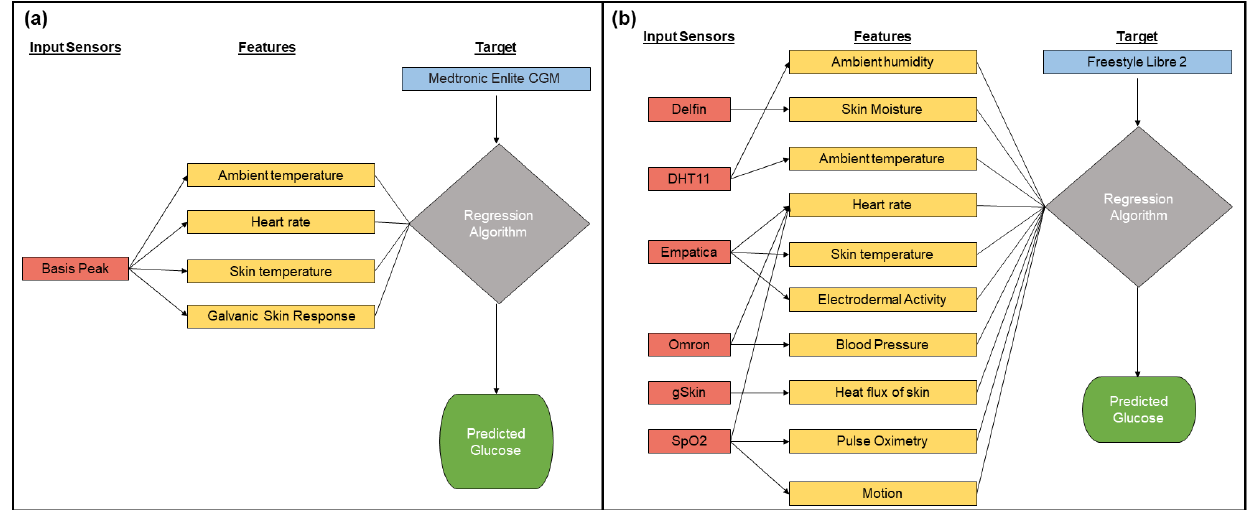
Figure 1. Sensors and their features for the ( a ) OhioT1DM and ( b ) UofM datasets.